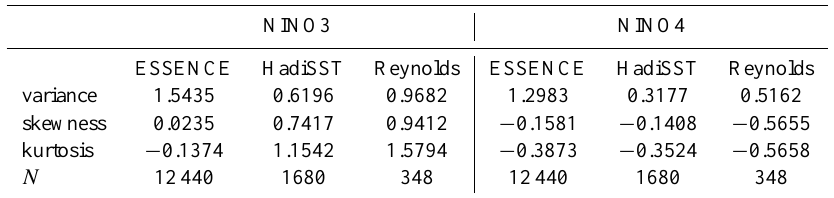
Fig. 2. Skewness kurtosis scatter plot for SST from the Reynolds analysis and the ESSENCE data set. The data points relate to fixed locations, which are collected in lati- tudinal bands. Points can not be situated in the grey area as the general statistical bound requires that kurtosis ≥ skewness 2 − 2 . The drawn curve relates to the lower parabolic bound kurtosis ≥ 3/2 skewness 2 (Sura and Sardeshmukh, 2008).